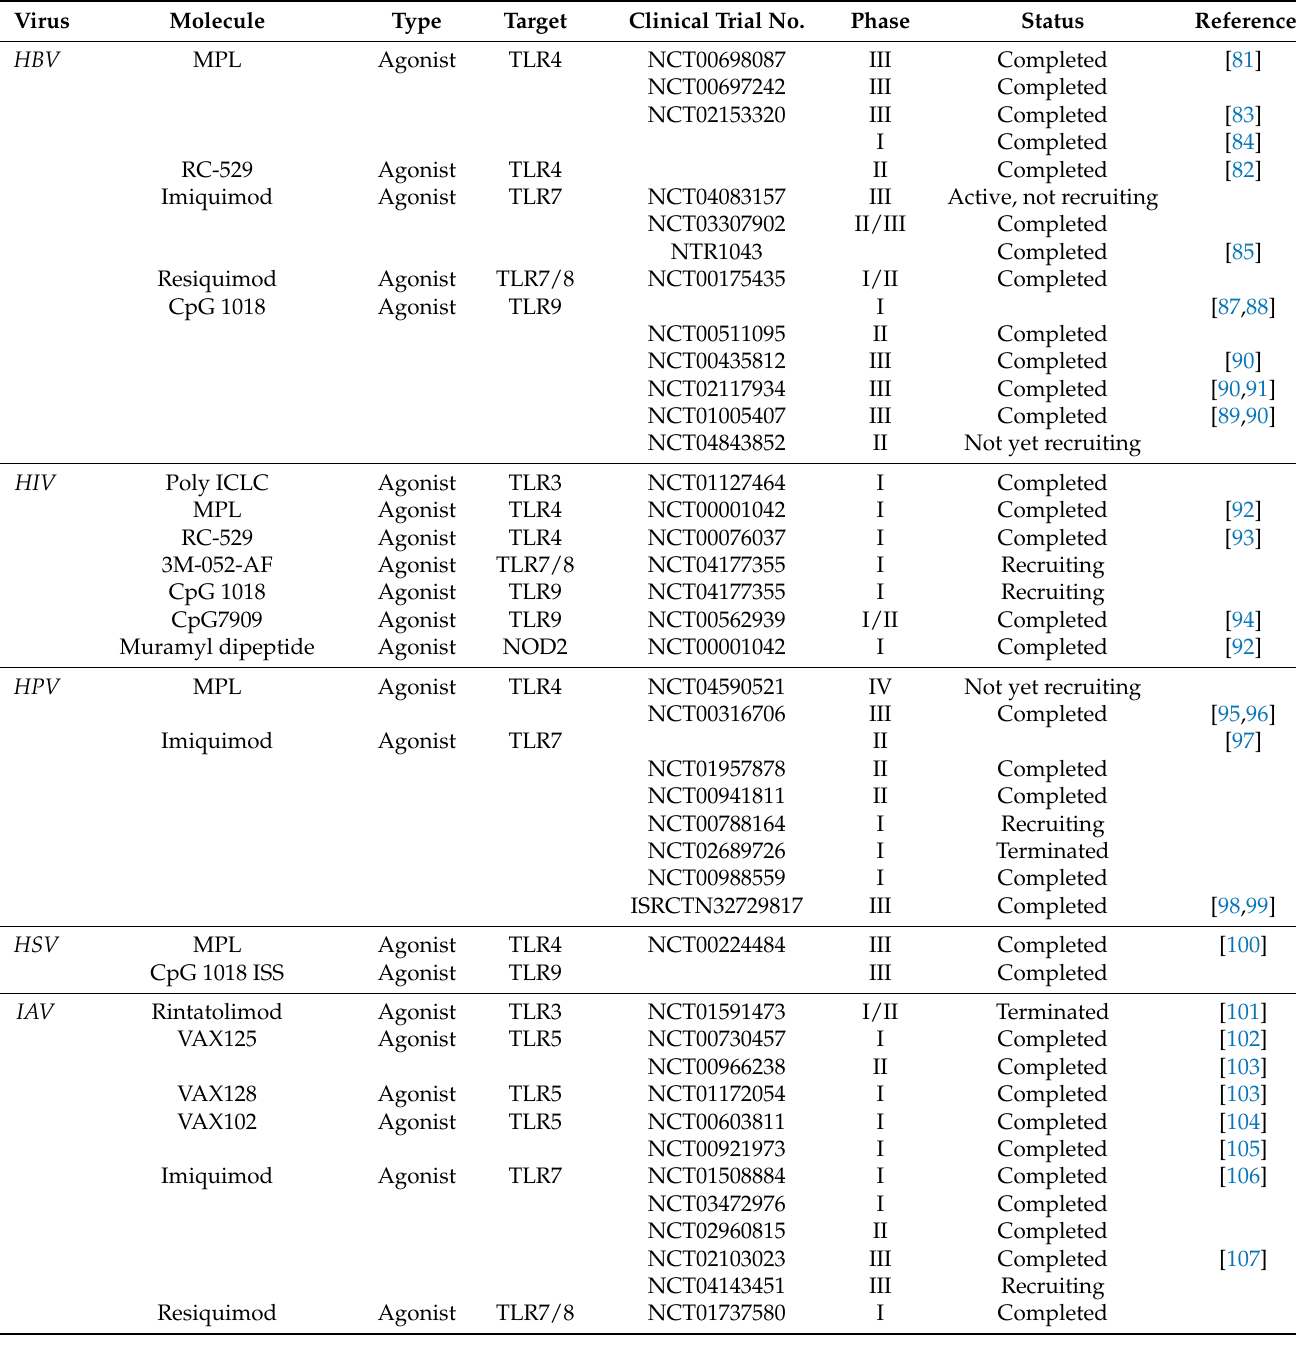
Table 2. Shown in the table is a list of PPR agonists that have been tested in clinical trials as vaccine adjuvants. Indicated is the viral infection, the name of the molecule, its target and the clinical trial information such as the trial number, the phase it has reached and the current status. HBV—hepatitis B virus; HIV—human immunodeficiency virus;